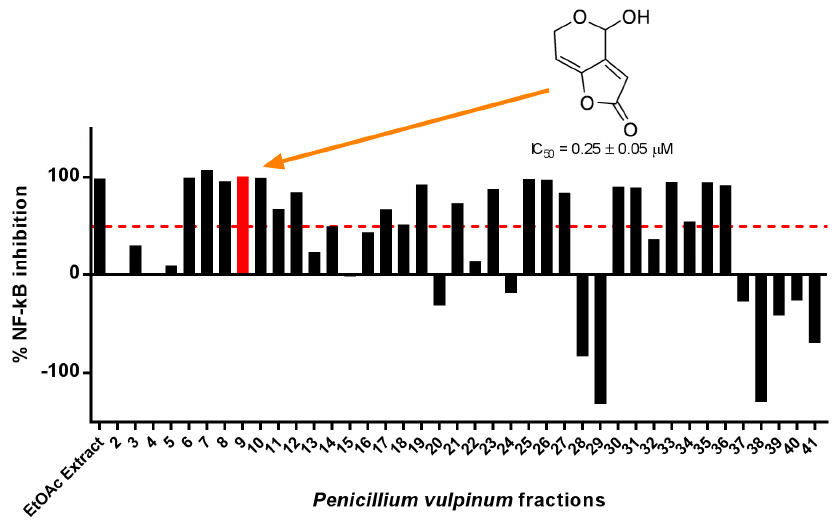
Figure 1 . Cultured P. vulpinum was extracted in ethyl acetate (EtOAc) and fractionated by flash chromatography using two C18 columns and a linear gradient of H 2 O + formic acid (FA) 0.1% and acetonitrile (ACN) + FA 0.1% from 98:2 to 2:98 at 14 mL/min for 200 min. Fractions were tested for their ability to inhibit TNF- α -induced NF- κ B activity in HEK293 cells at 20 μ g/mL. Fractions able to inhibit more than 50% of NF- κ B activity were considered active. F9 was the most interesting in terms of activity and available amount. Patulin was isolated from this fraction and inhibited NF- κ B with an IC 50 value of 0.25 ± 0.05 µ